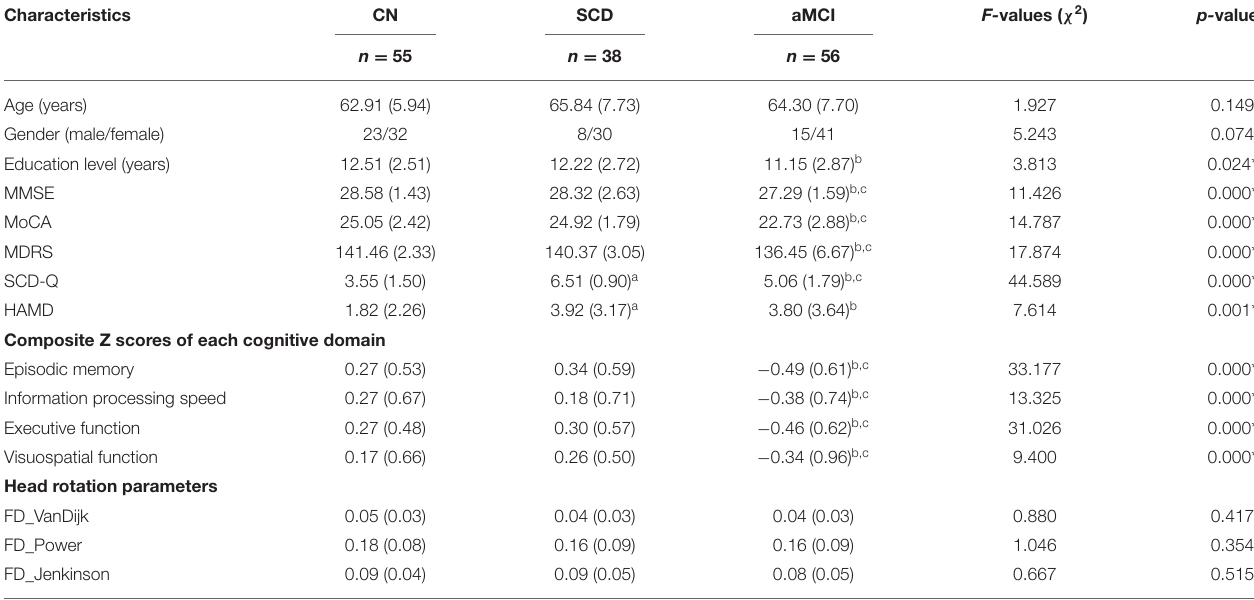
TABLE 1 | Demographics, clinical measures, and head rotation parameters of aMCI, SCD, and CN subjects.